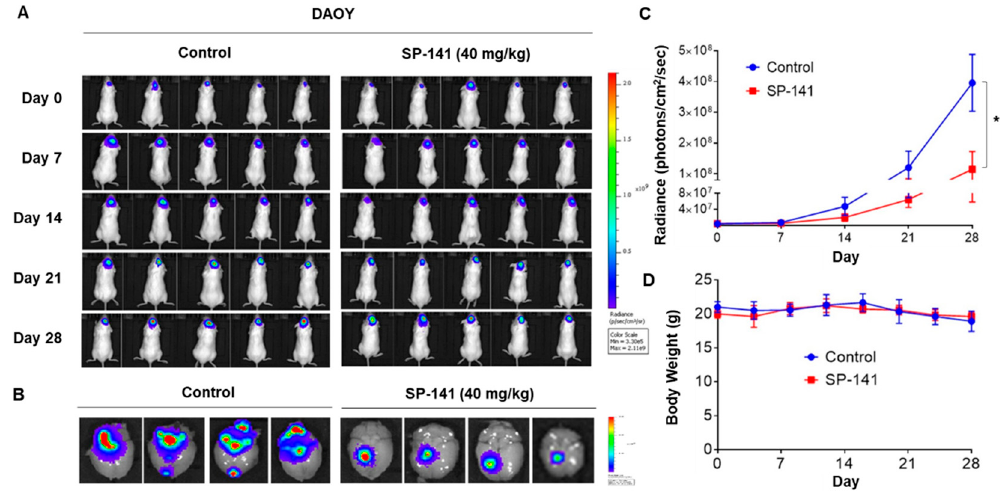
Figure 4. SP-141 shows excellent antitumor activity against DAOY human medulloblastoma intracranial xenografts. ( A ) Representative images of bioluminescence acquisition of brain tumors on day 0, 7, 14, 21, and 28 of treatment. The dose of SP-141 and treatment were the same as described in the legend to Figure 3A. ( B ) Ex-vivo bioluminescence from the brains of control (left row) and SP-141-treated (right row) mice. The scale indicates fluorescence intensity in terms of radiant e ffi ciency (p / sec / cm 2 / Sr). ( C ) The average time-dependent changes in bioluminescence radiance in DAOY xenografts in mice receiving SP-141, treated over 4 weeks (* p < 0.01). ( D ) The average body weights of the mice were plotted during SP-141 treatment.